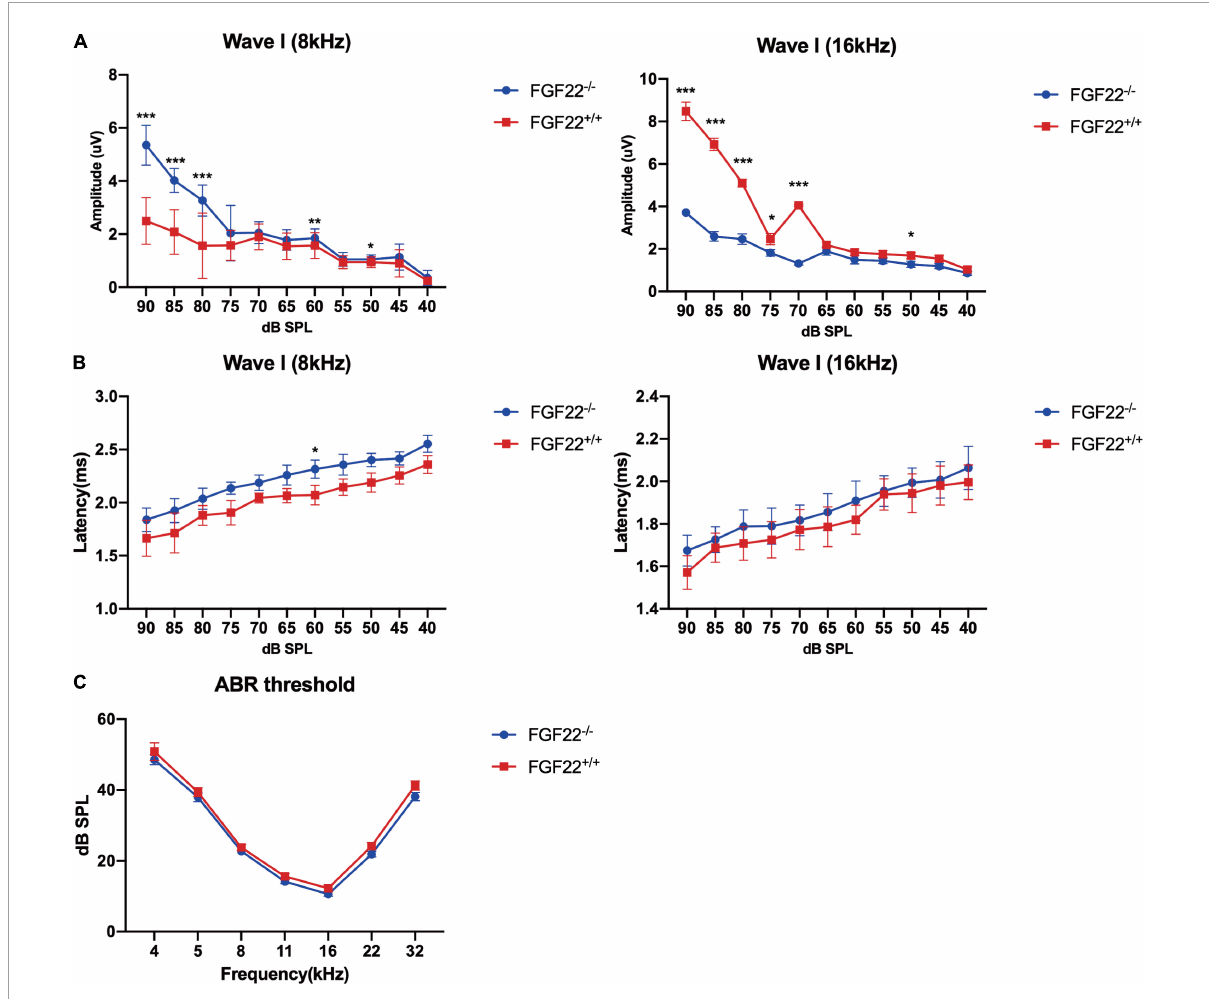
FIGURE1 Auditory function parameters in the Fgf22 + / + and Fgf22 − / − groups. (A) Mean amplitudes of the ABR wave I in the Fgf22 + / + and Fgf22 − / − groups at 8 and 16 kHz. (B) Mean latency values of the ABR wave I in the Fgf22 + / + and Fgf22 − / − groups at 8 and 16 kHz. (C) Mean values of the ABR threshold in the Fgf22 + / + and Fgf22 − / − groups at 8 and 16 kHz. Data are expressed as the mean ± SD, statistical significance was assessed with two-way ANOVA followed by Bonferroni post hoc test, * P < 0.05, ** P < 0.01, *** P < 0.001.